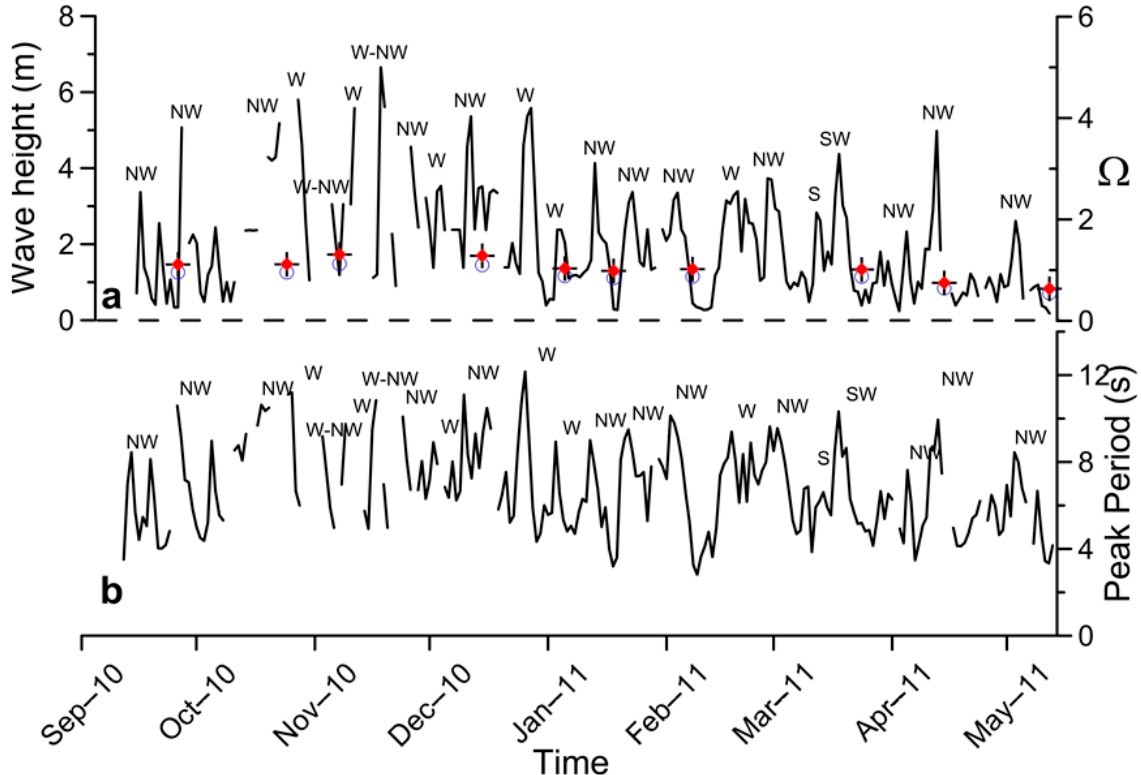
Figure 6. ( a ) The significant wave height and Ω value (mean values for the period between the topographic survey) on the following beaches: Is Arutas (red dot), Mari Ermi (blue circle) and Maimoi (black cross). ( b ) The wave peak period.